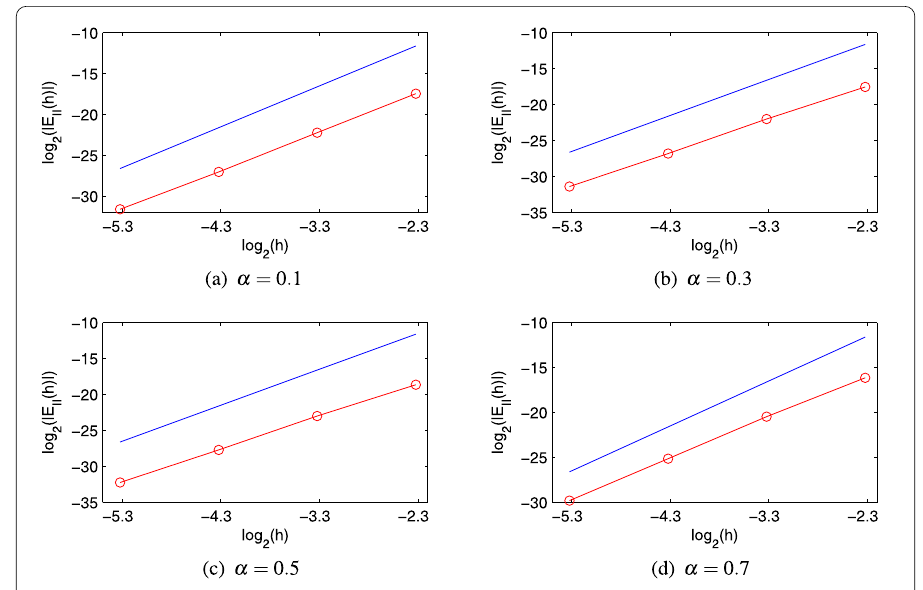
Figure 8 The experimentally determined orders of convergence for algorithm II at t = 1 for (31) with ν = 3.45 ( y ( t ) is not sufficiently